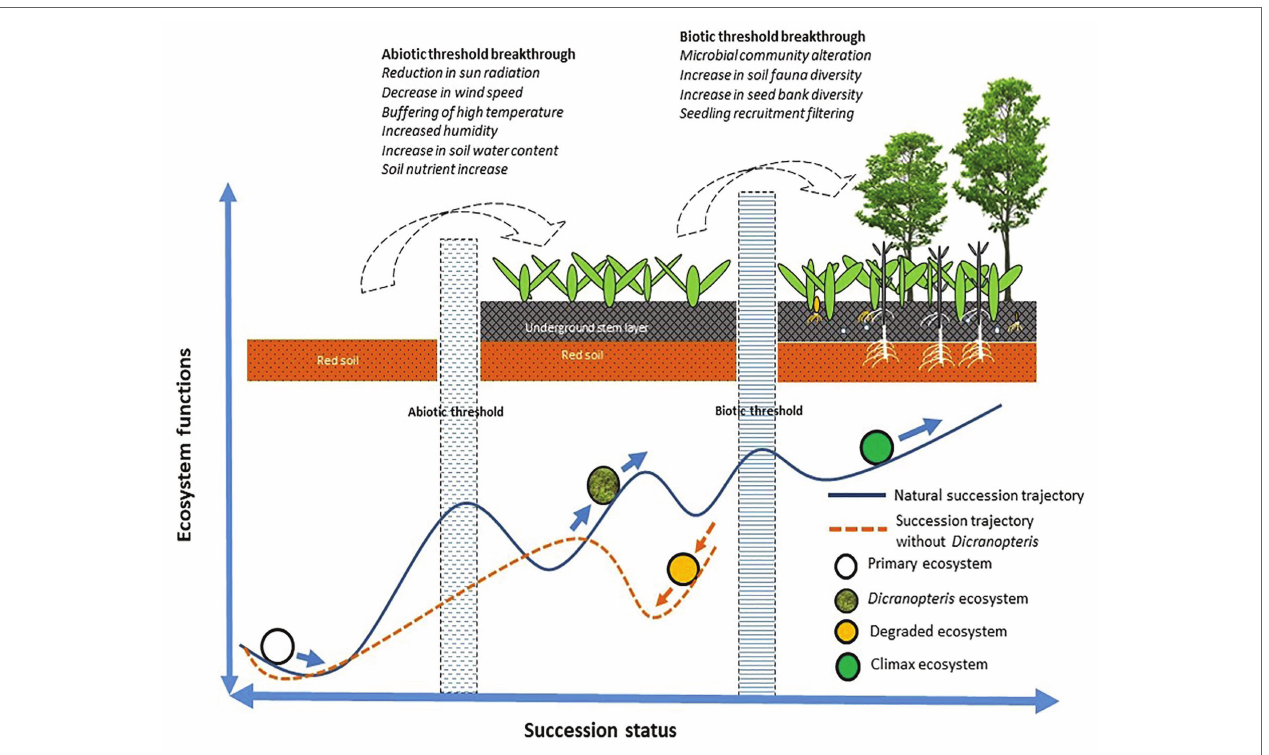
FIGURE 3 | A model of how Dicranopteris communities facilitate to overcome the abiotic and biotic thresholds of succession (based on Sun et al.,